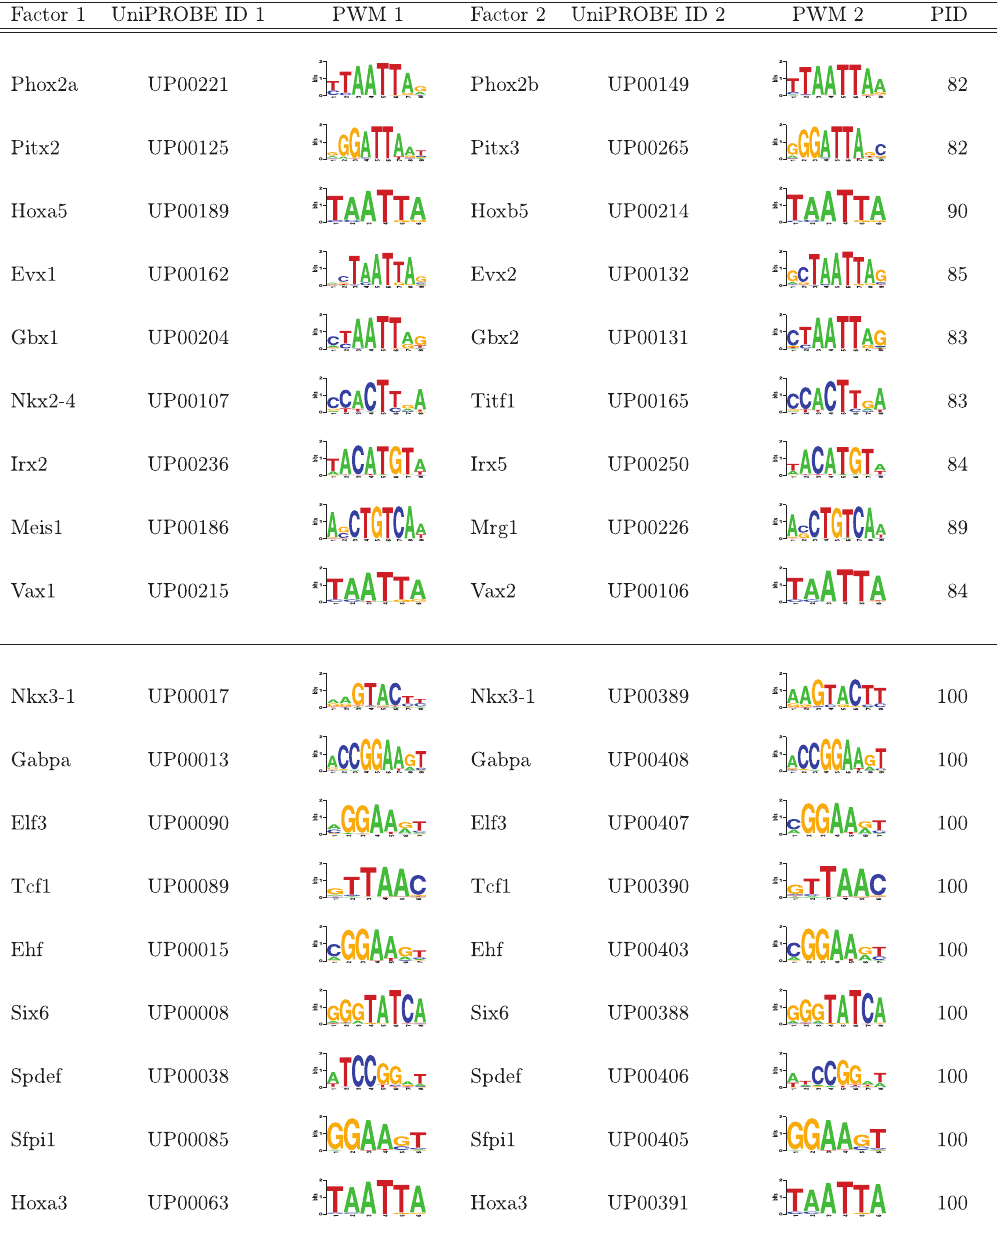
at http://dodoma.systemsbiology.netdodoma.systemsbiology.net.